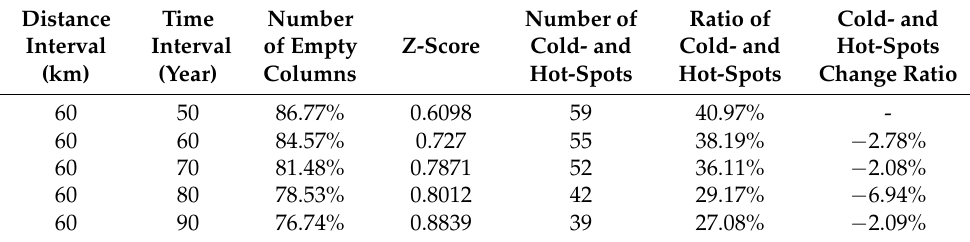
Table 4. Space-time cube spatio-temporal scale effect